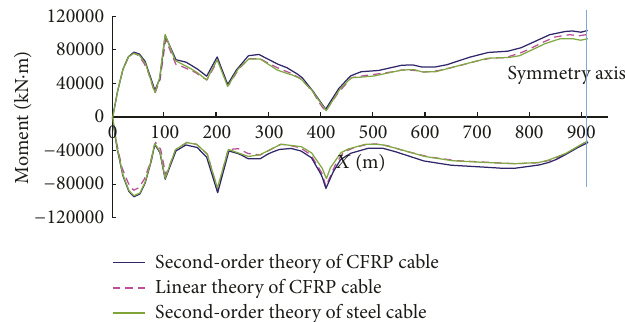
Figure 7: Envelope diagram of girder’s bending moments.